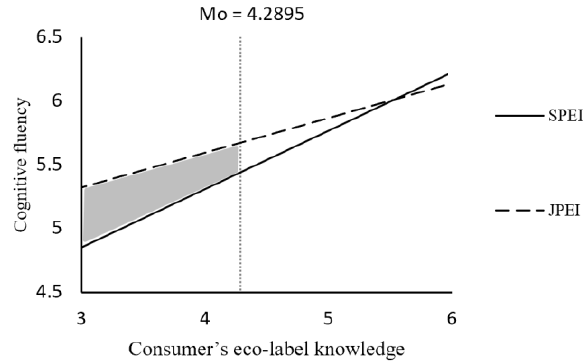
Figure 2. The interactive effect of eco-label information presentation and consumer’s eco-label knowledge (Study 1). Note: the shaded area is the Johnson–Neyman significant area.